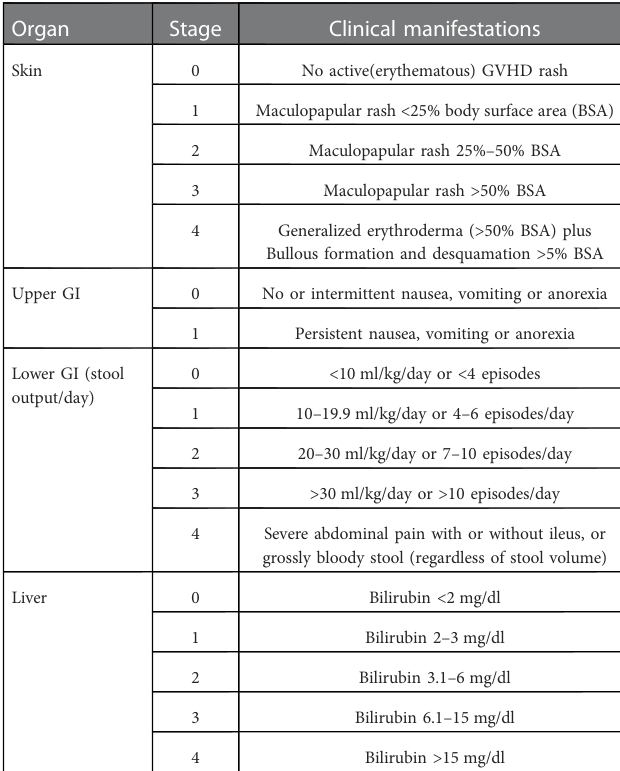
TABLE 5 Grading system for CRS proposed by Lee et al. TABLE 6 Clinical manifestations and stages of aGVHD